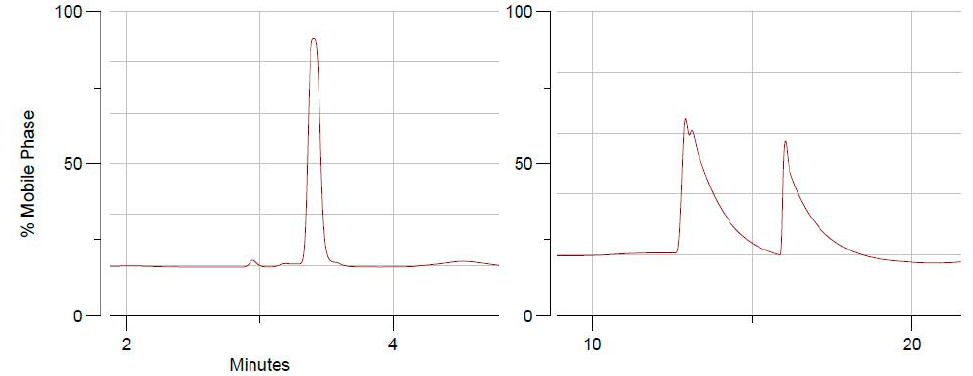
Figure 1. Chiral-HPLC separation of compound 1 (pure enantiomer— left ) and compound 3 (diasteromeric mixture— right ).